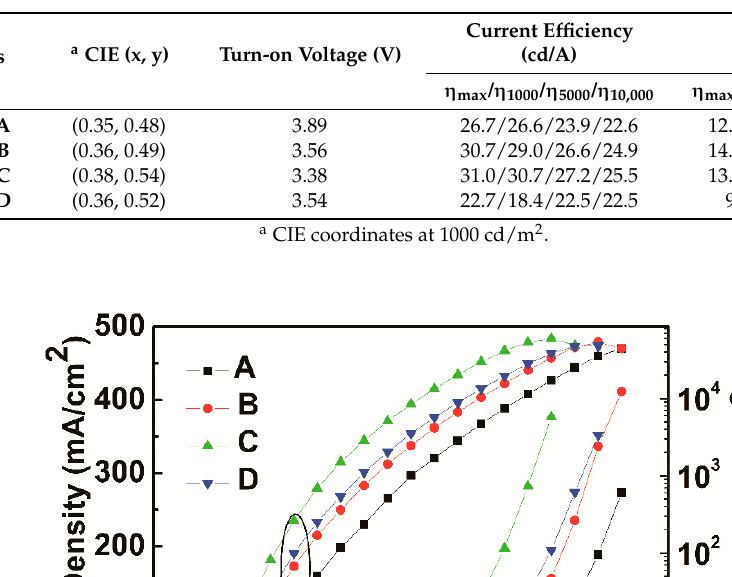
Table 1. Performance characteristics of devices A–D. η max : Maximum efficiency, η 1000 , η 5000 , η 10,000 : efficiencies at 1000, 5000, and 10,000 cd/m 2 .